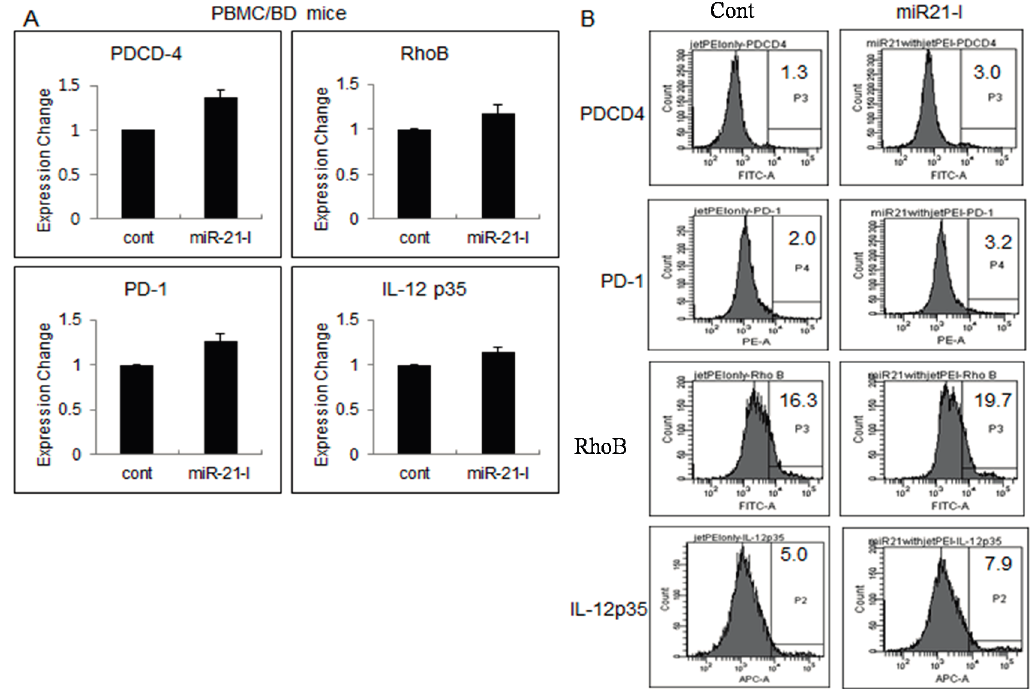
Figure 4. miR-21 inhibition by antagomir up-regulated several genes in BD mice by time with FACS analysis in PBMC isolated from BD mice ( B